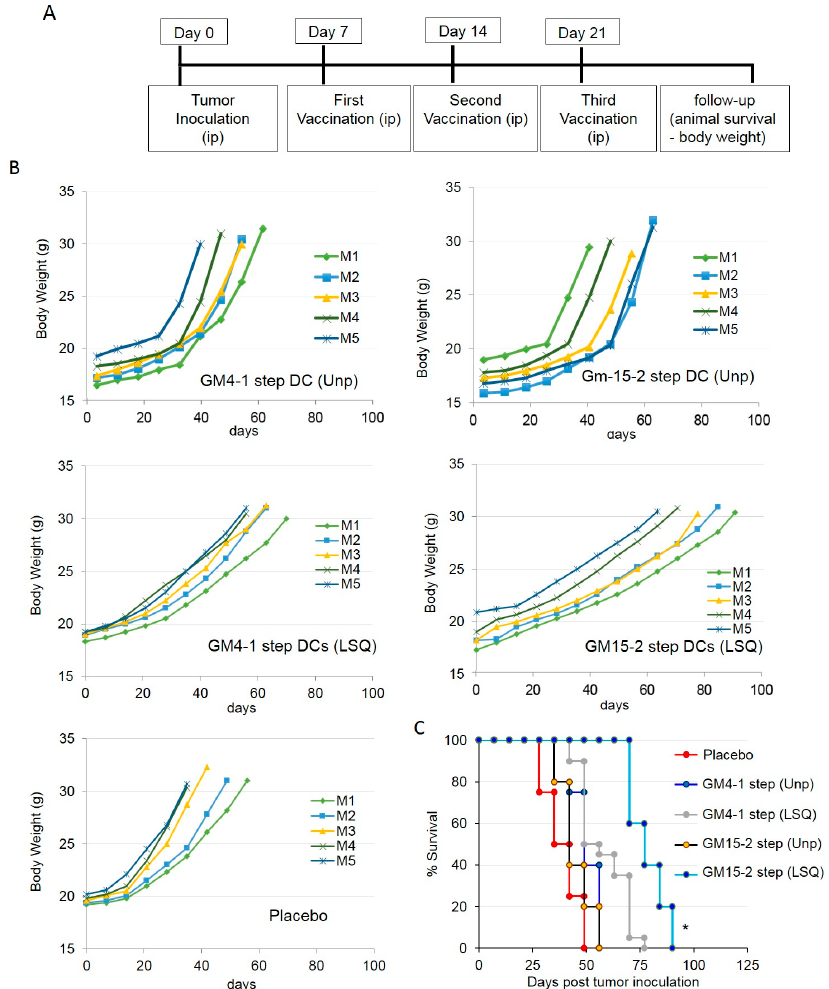
Figure 4. DCs matured with a two-step protocol in the presence of anti-CD40 and anti-IL10R antibodies for 24hr, followed by LPS/IFN γ /CpG stimuli prolong animal survival in a vaccination mouse model of ovarian cancer. ( A ) Vaccination scheme: mice were inoculated i.p. with ID8 cells at day 0, followed by i.p. vaccination with the indicated DC formulations (pulsed with an ID8 tumor cell lysate treated with squaric acid (LSQ) or kept unpulsed (Unp)) at day 7, 14 and 21 ( n ≥ 5 for each group). ( B , C ) Body weight and animal survival were evaluated and plotted in Kaplan–Meier cumulative survival plots. Student’s t test results (comparing GM15-2 step DCs (LSQ) to both GM4-1 step DCs (LSQ) and placebo) is indicated with an asterisk: * p < 0.05. (CpG: CpG oligonucleotides; DC: dendritic cells; IFN- γ : interferon- γ ; LPS: